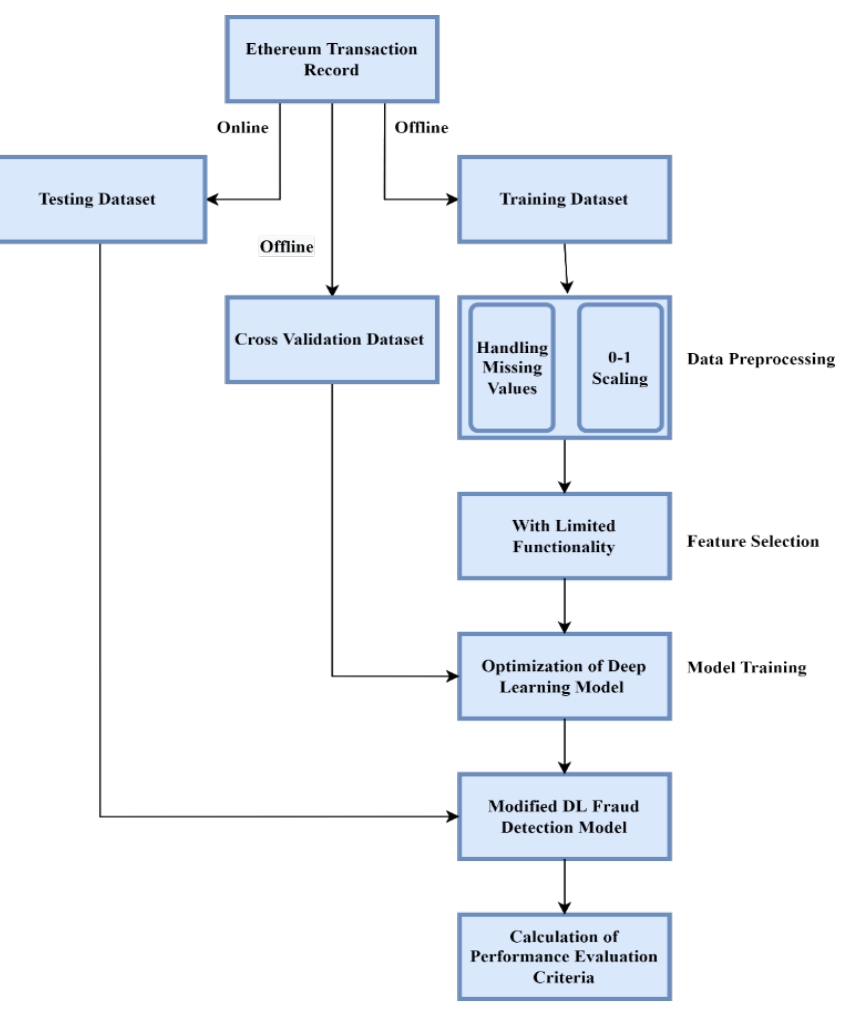
Figure 1. Workflow of the process followed in the study.